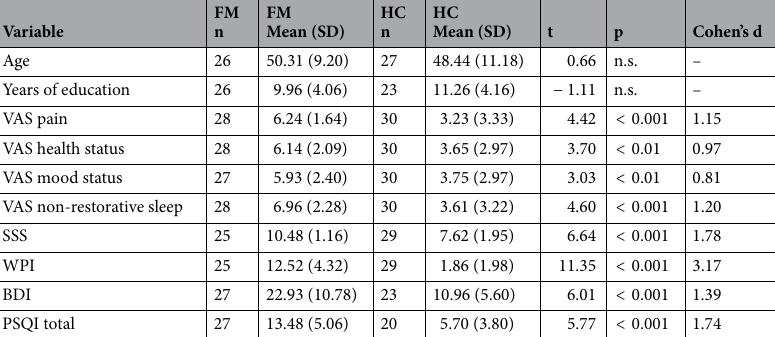
Table 3. Mean values (standard deviations in parentheses) of the demographic and clinical variables measured for the patients with fibromyalgia (FM) and healthy controls (HC). Results of the t-tests comparisons and effect sizes (Cohen’s d). VAS: Visual Analogue Scale; SSS: Symptom Severity Score; WPI: Widespread Pain Index; BDI: Beck Depression Inventory; PSQI: Pittsburgh Sleep Quality Index; n.s.: non-significant.